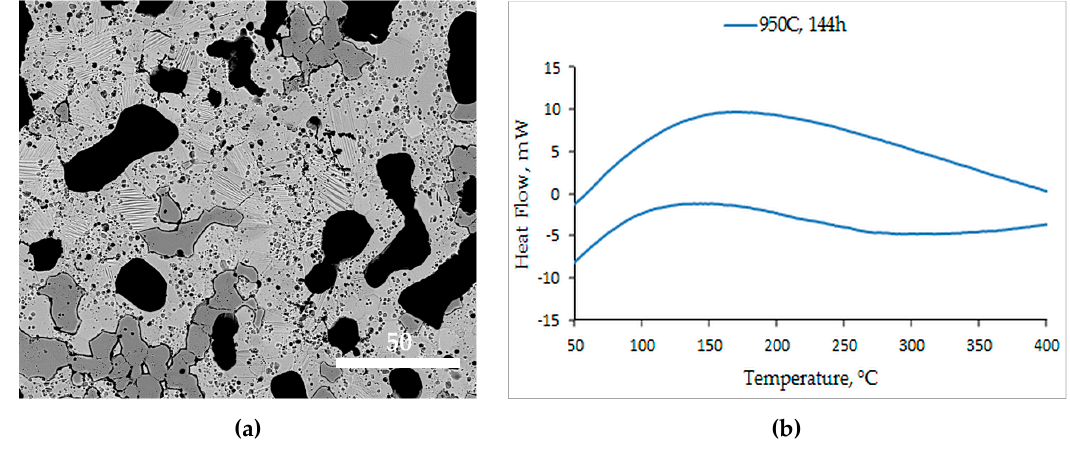
Figure 13. ( a ) BSE micrograph of S950b4 and ( b ) DSC curve of S950b4.